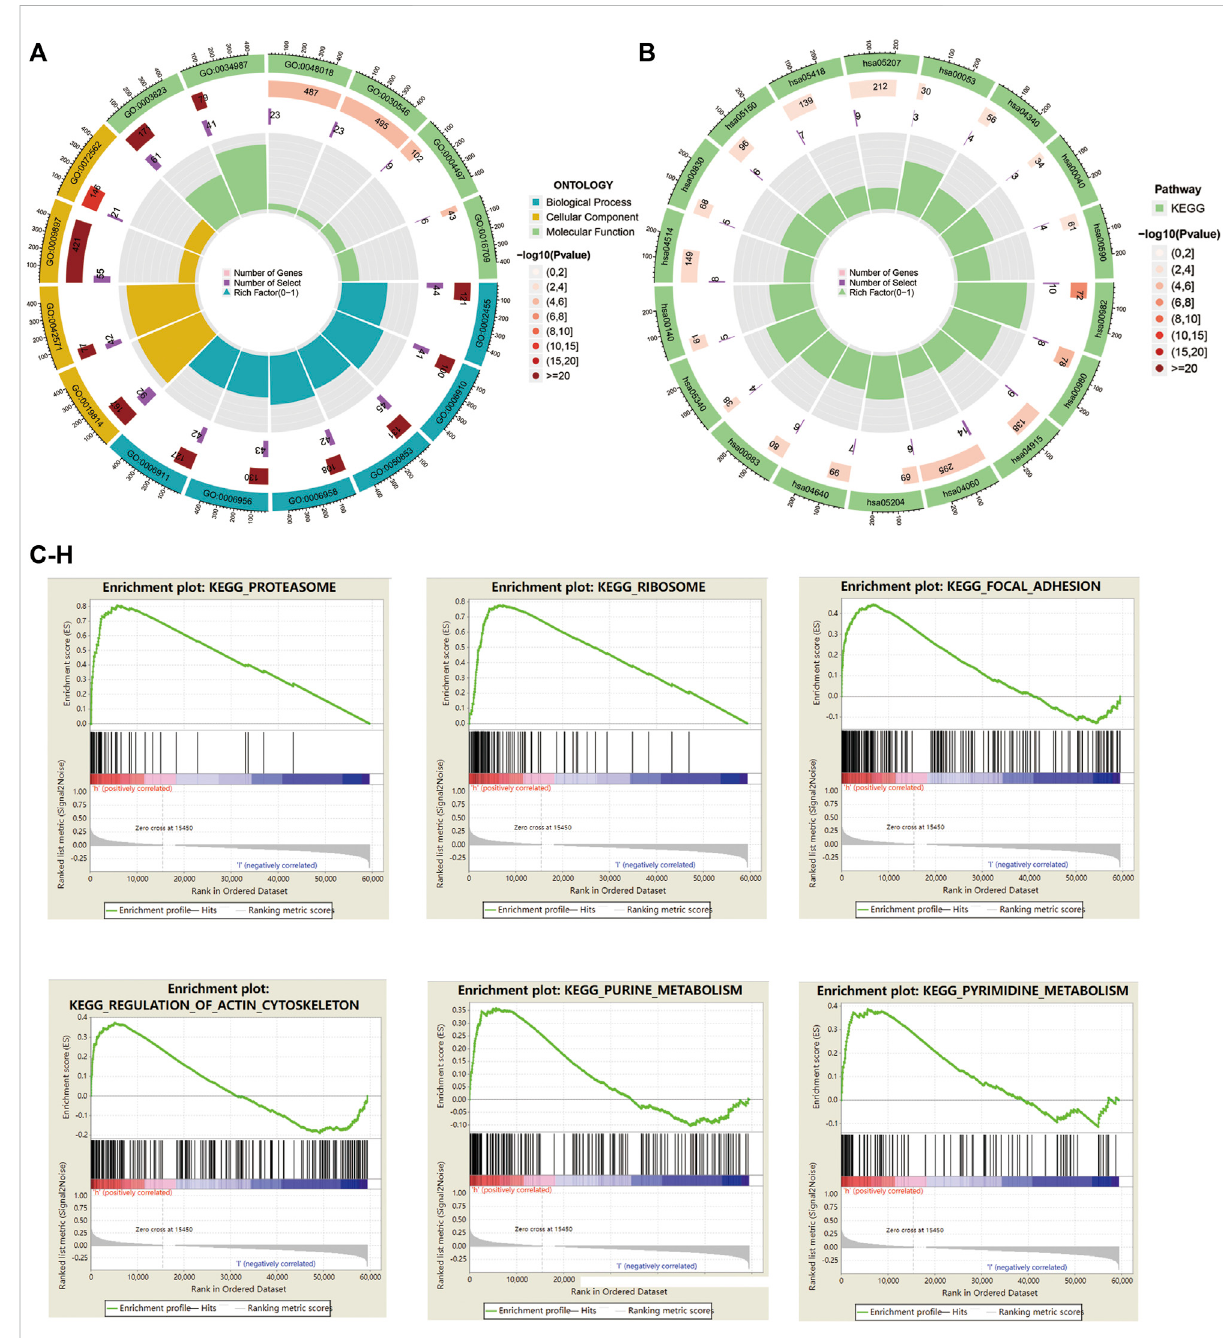
FIGURE 7 GO, KEGG enrichment, and GSEA analysis in HNSC patients based on the prognostic signature. (A) The circle graph showed top GO signaling pathwaysinvolvedBP,MF,andCCbiologicalprocesses. (B) ThecirclegraphshowedtopKEGGsignaling pathways. (C – H) GSEAanalysisshowed top pathways enriched in the high-risk